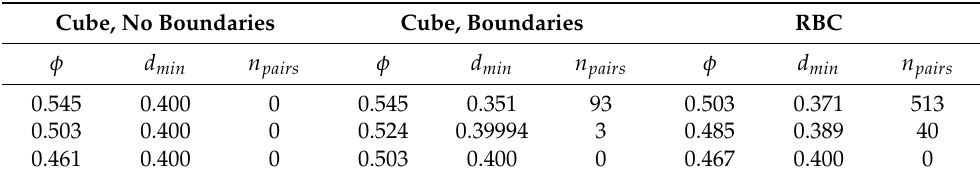
Table 3. Determining the appropriate particle-volume fraction φ . d min ( µ m) is the minimal distance of two particles (over 1000 replications), n pairs is the maximum (over 1000 replications) number of particle pairs that are closer than 2 r h , where r h = 0.2 µ m. Cube, No Boundaries Cube, Boundaries RBC φ d min n pairs φ d min n pairs φ d min n pairs 0.545 0.400 0 0.545 0.351 93 0.503 0.371 513 0.400 0 0.503 0.400